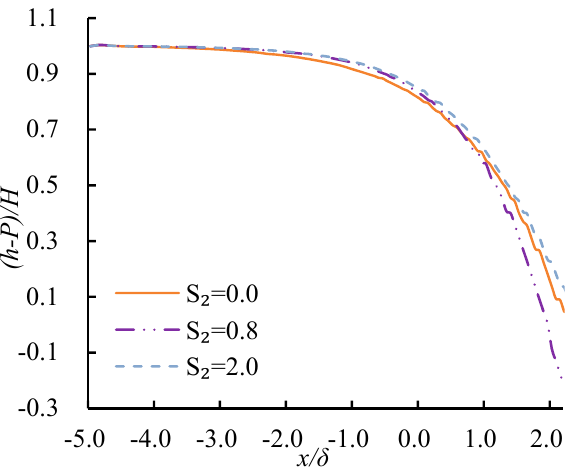
Figure 10. Comparison of free surface profiles over weirs with H / δ = 1.41 at S 1 = 1.0 for S 2 = 0.0, 0.8 and 2.0.